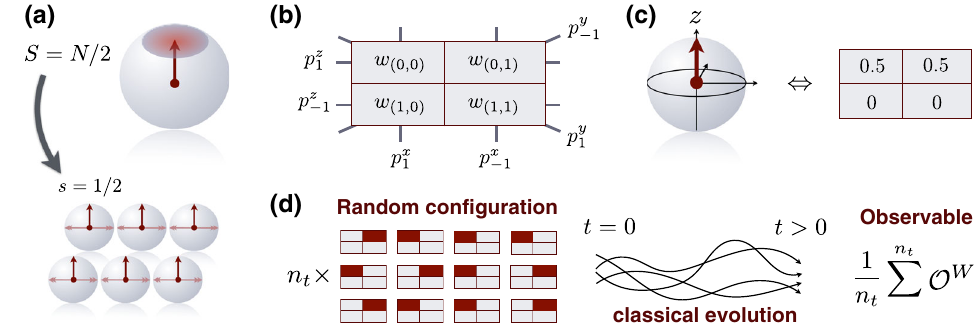
FIG. 1. Discrete phase space and the DTWA. (a) Our method considers the quantum uncertainties of N spin- 1 = 2 particles individually, rather than the noise of the collective spin S ¼ N= 2 . (b) The quantum physics of a spin- 1 = 2 particle can be fully described by a discrete four-point Wigner quasiprobability distribution, w . The probability for a spin to point along the (cid:3) x , (cid:3) y , and (cid:3) z directions ( p x;y;z ð p;q Þ given by the sum over the vertical, diagonal, and horizontal lines in phase space, respectively [20]. (c) Discrete Wigner function of a spin pointing along z . (d) The idea behind the DTWA is to (i) randomly sample the phase points for each spin according to w (ii) calculate the time evolution according to classical equations, and (iii) evaluate observables in phase space from the statistical mixture of n t